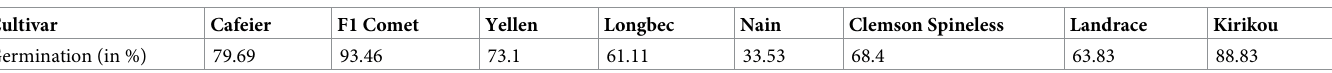
Table 5. Germination percentage of okra cultivars. Cultivar